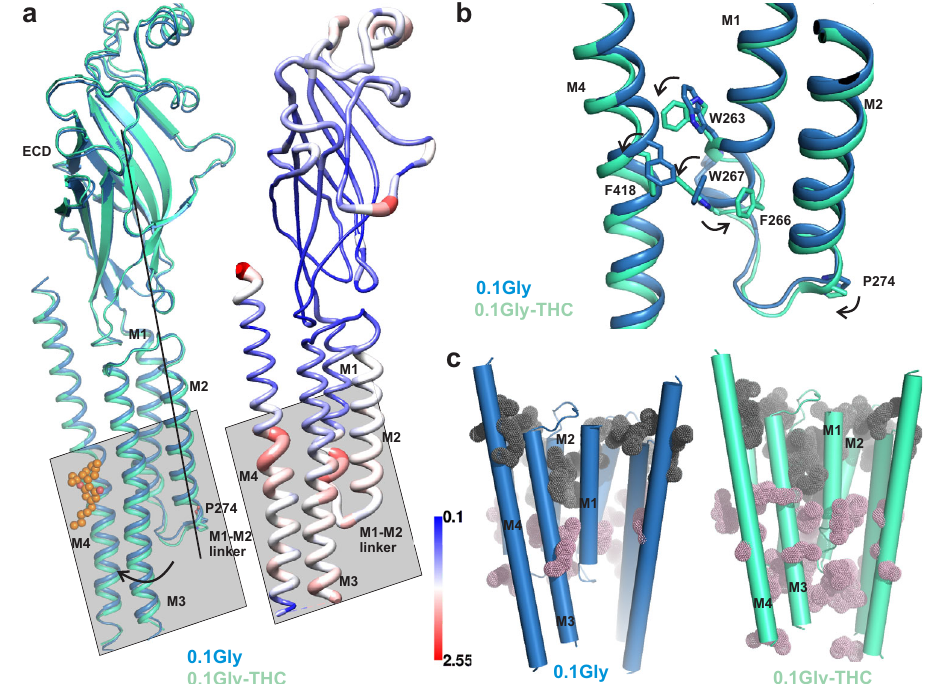
Fig.3|THC-inducedconformationalchangeswithintheTMD.a Asingle-subunit alignment of GlyR-0.1gly and GlyR-0.1gly-THC structures highlighting the overall conformationalchangesassociatedwithTHCbinding(left).Puttyrepresentationof pairwise root mean square deviation (RMSD) for the GlyR-0.1gly and GlyR-0.1gly- THC structures (right). The gray box points out regions that show most positional